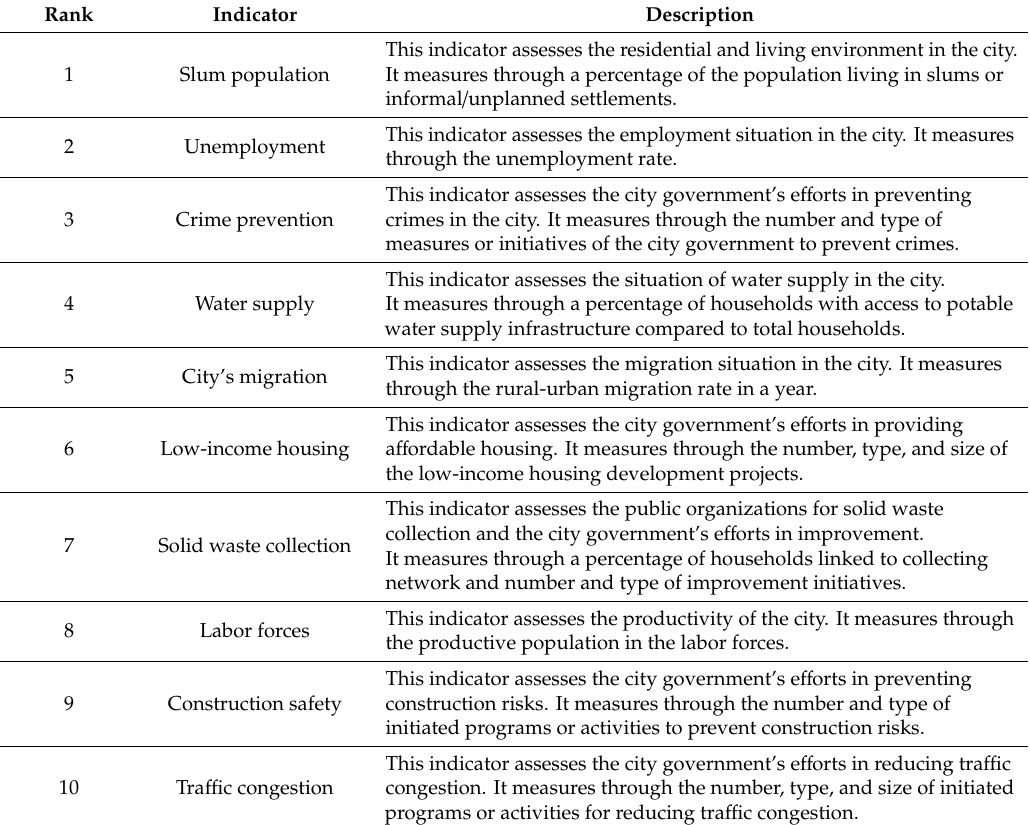
Table 5. Top 10 assessment indicators for sustainable city development and management in